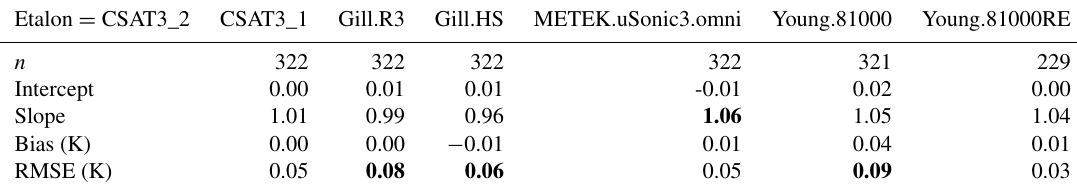
Figure 7. Comparison of the standard deviation of the sonic temperature σ T Table 5. Regression results for the comparison of the standard deviation σ T large deviations from the etalon are in bold (slopes deviating more than 5% from unity and absolute differences larger than